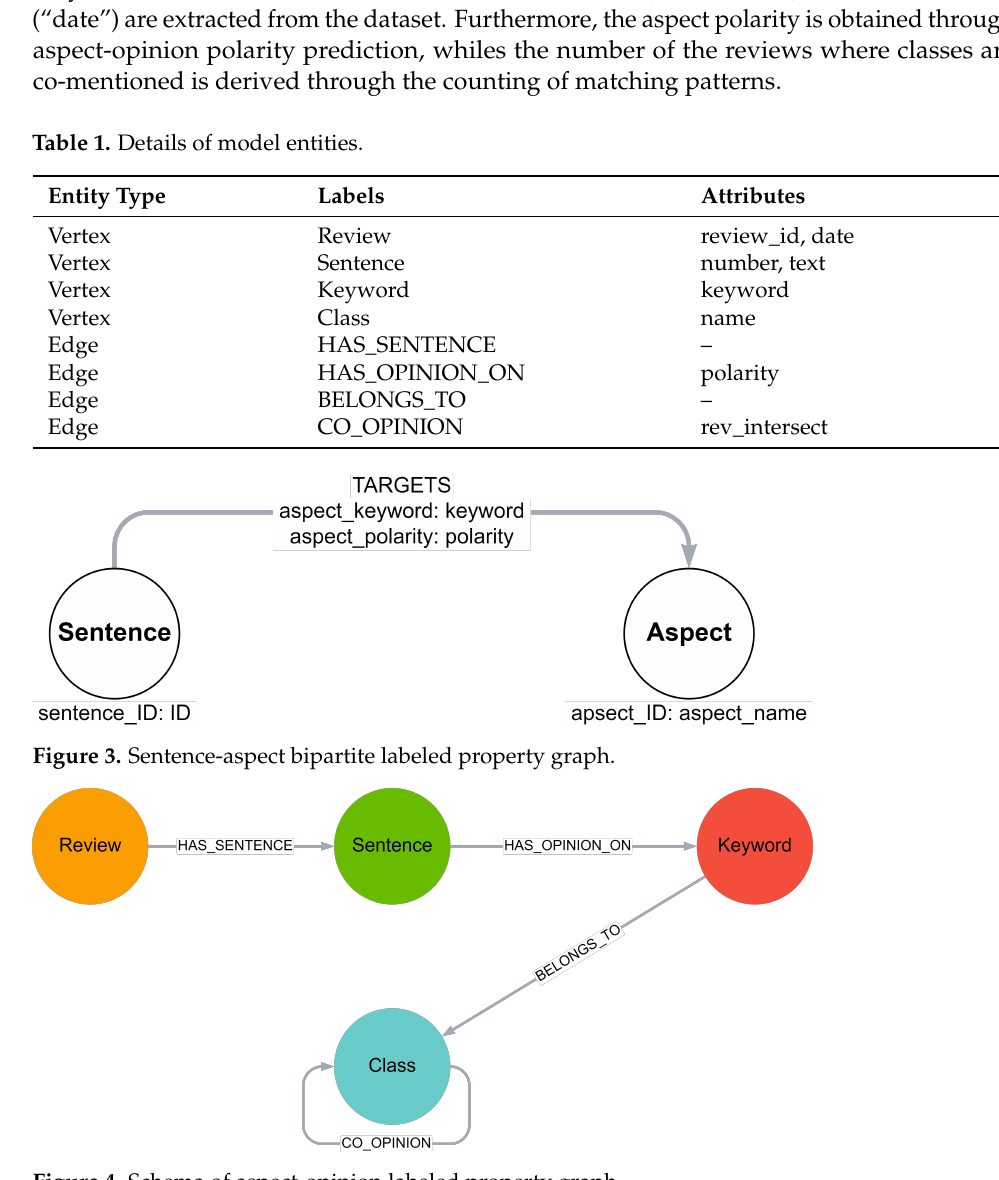
Figure 4. Schema of aspect-opinion labeled property